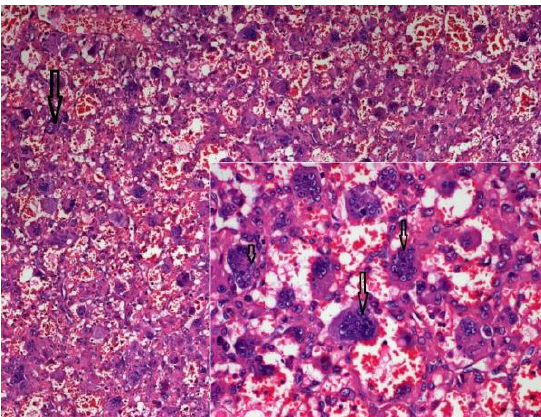
Figure 5. Histopathological image showing prominent vascular channels in which intervening stroma is loose edematous and shows scattered multinucleated giant cells (Arrow